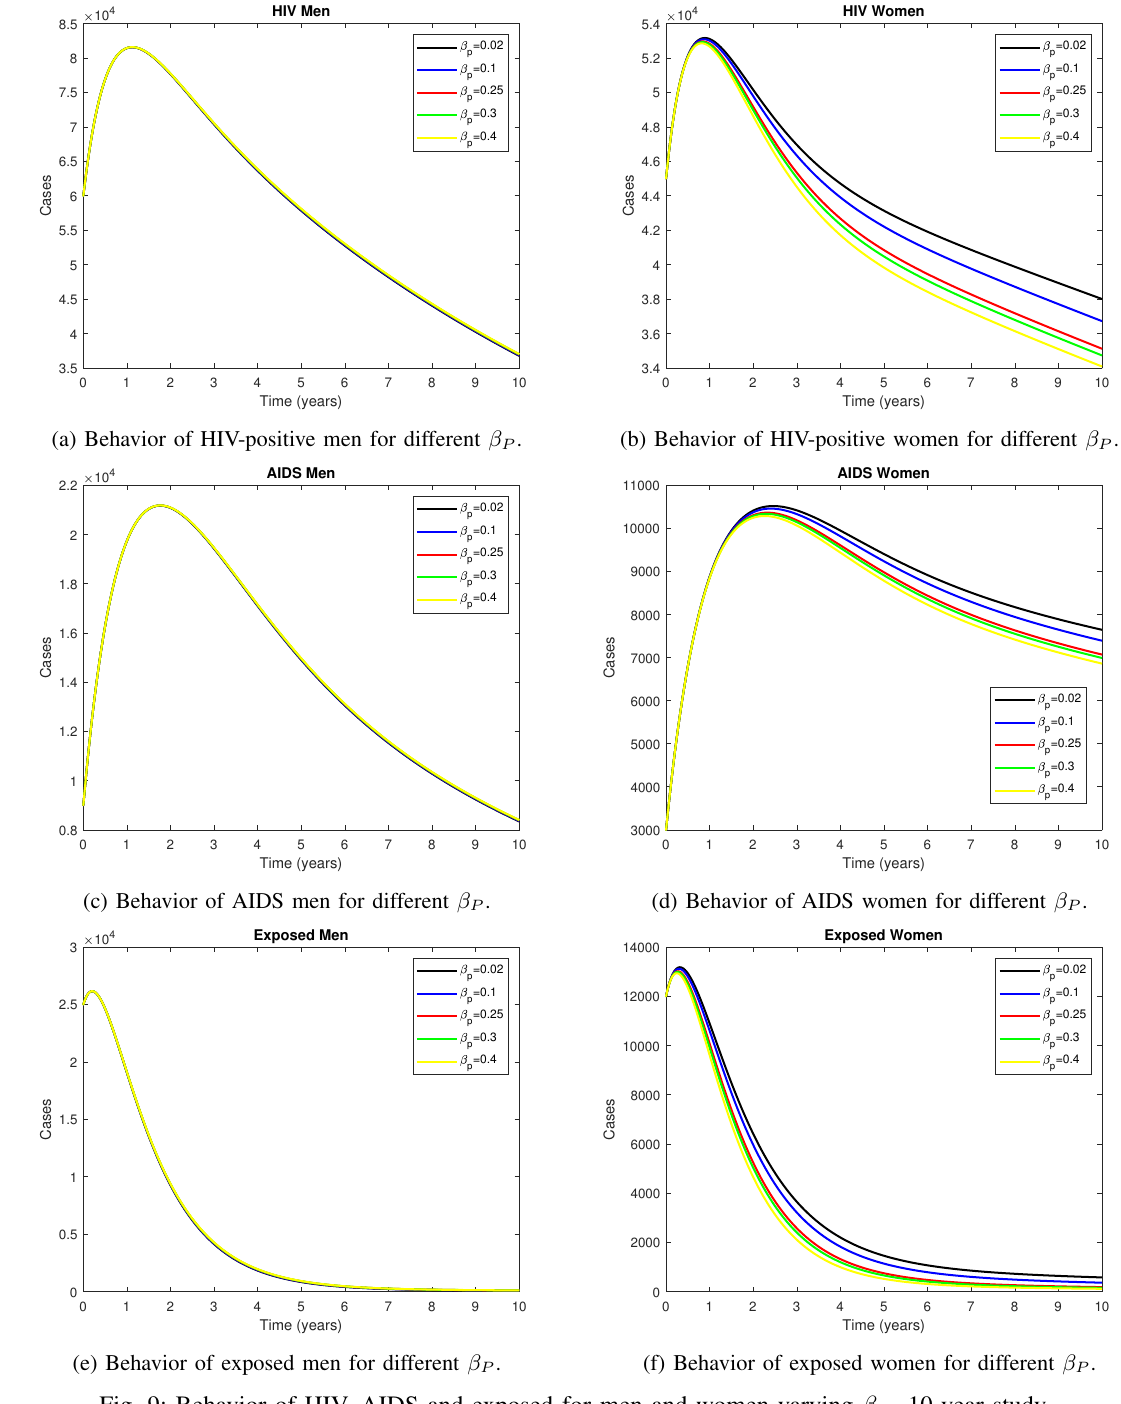
Fig. 9: Behavior of HIV, AIDS and exposed for men and women varying β P , 10-year